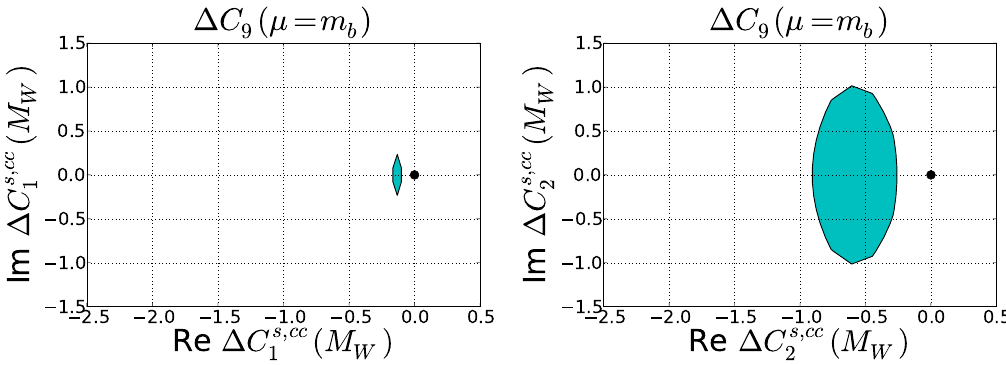
Figure 26 . Regions for NP, at 90% C.L., in the Re (cid:1) C s;cc Im (cid:1) C s;cc (right) planes allowed by the B physics anomalies related with the decay B ! K ( (cid:3) ) (cid:22) + (cid:22) (cid:0) . 2 The black dot corresponds to the SM